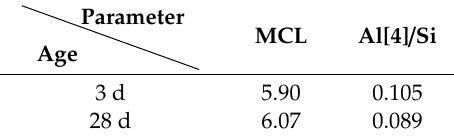
Table 3. Molecular chain length (MCL) and Al[4] / Si at di ff erent ages.